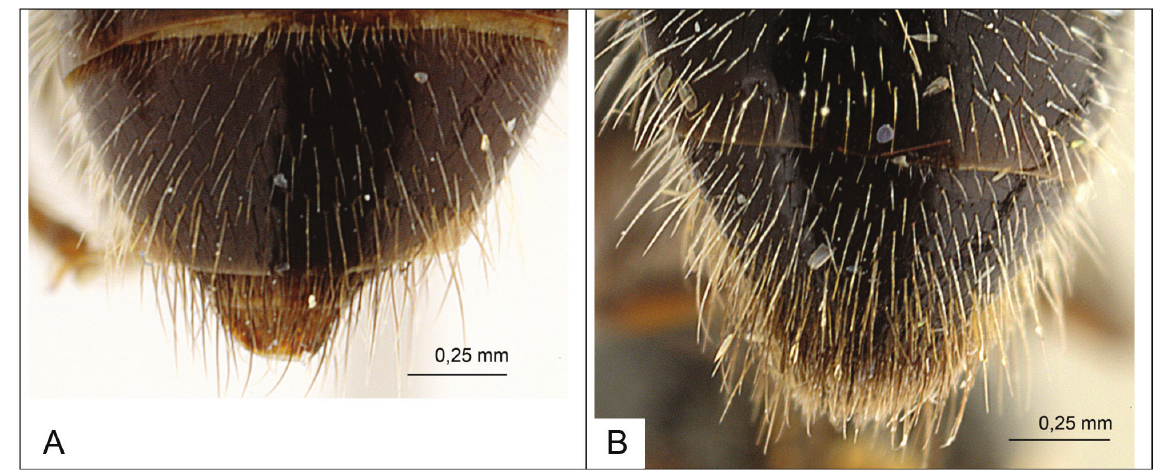
Fig. 6. Eupetersia yanegai sp. nov. A . ♂, end of metasoma with pygidial plate. B . ♀, end of metasoma without pygidial plate.